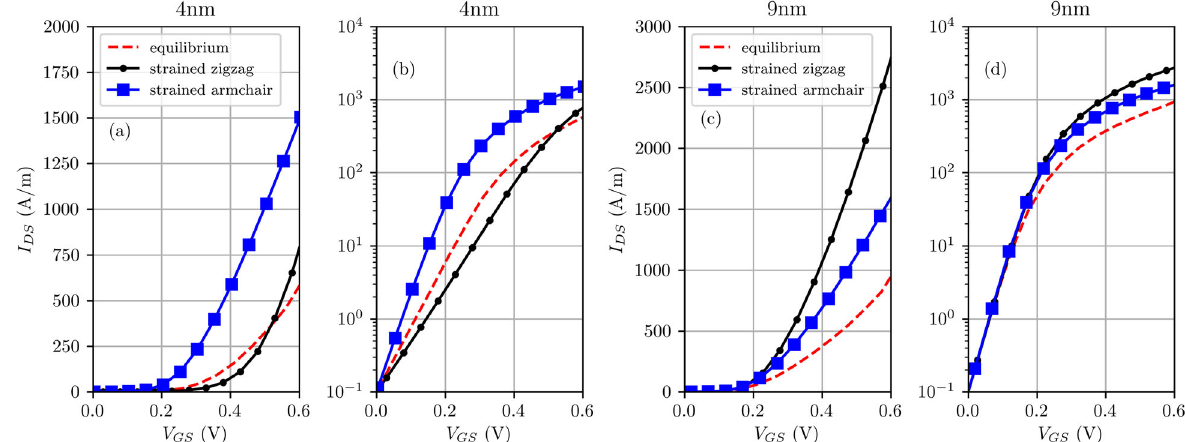
Fig. 6 Calculated transfer characteristics for MOSFETs based on As with an uniaxial strain of 2% along the zigzag direction. I DS – V GS in linear and logarithmic scale. Two different gate lengths ( L G = 4 and 9 nm) and transport directions (armchair and zigzag) are considered.